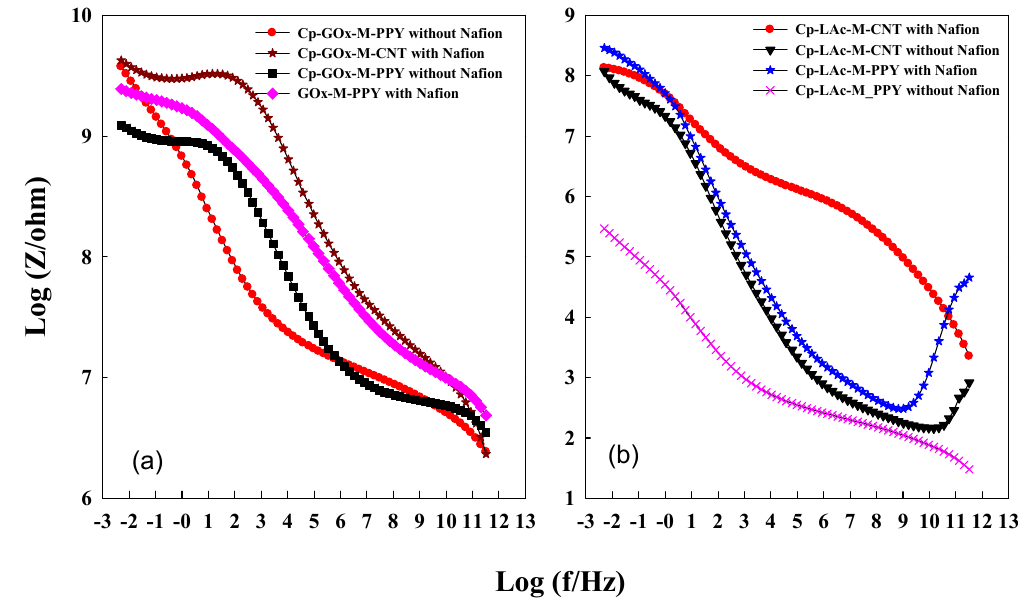
Figure 10. Bode plot of ( a ) bioanode impedance and ( b ) biocathode impedance for EBFC with and without Nafion solution.